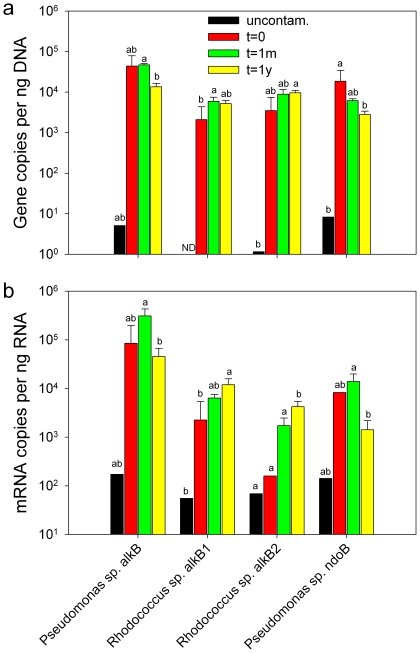
Hydrocarbon-degrading gene relative abundance and expression.
Pseudomonas alkB and ndoB and Rhodococcus alkB1 and alkB2 genes (a) relative abundance and (b) relative expression in t = 0, t = 1m, t = 1y and uncontaminated Alert biopile soils. Different letters within a group of bars (e.g. Pseudomonas sp. alkB) mean significantly different averages (P<0.05) (For t = 0, N = 2; for t = 1m, N = 4; for t = 1y N = 4; for uncontaminated, N = 1).